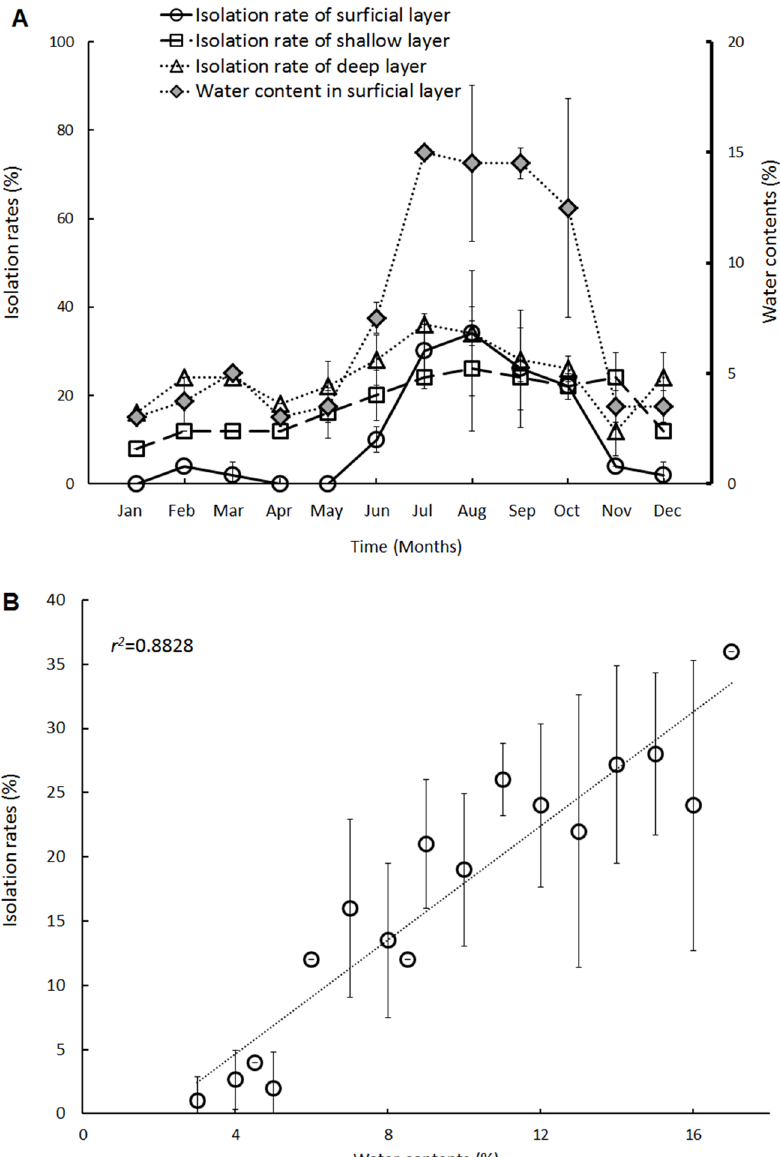
Fig 2. The isolation rate distribution and correlations between the isolation rate and moisture content. The soil ( < 10 cm, superficial layers, circle; 30 cm, shallow layer, square; 60 cm, deep layer, hollow triangle) was sampled in a vertical distribution. The average monthly isolation rates of B . pseudomallei from each layer are shown. The moisture (water) contents in the superficial layer are labeled with grey diamonds (A), and the isolation rates are shown for the indicated moisture contents